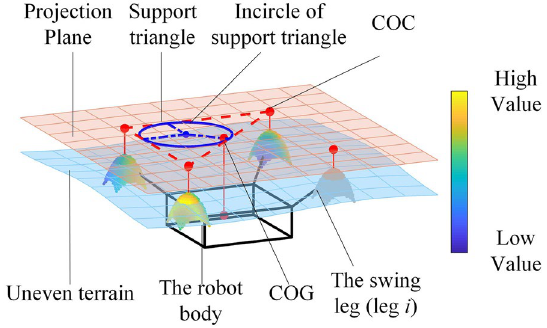
Figure 6 Magnitudes employed to characterize the motion stability of quadruped robot by using Inverted